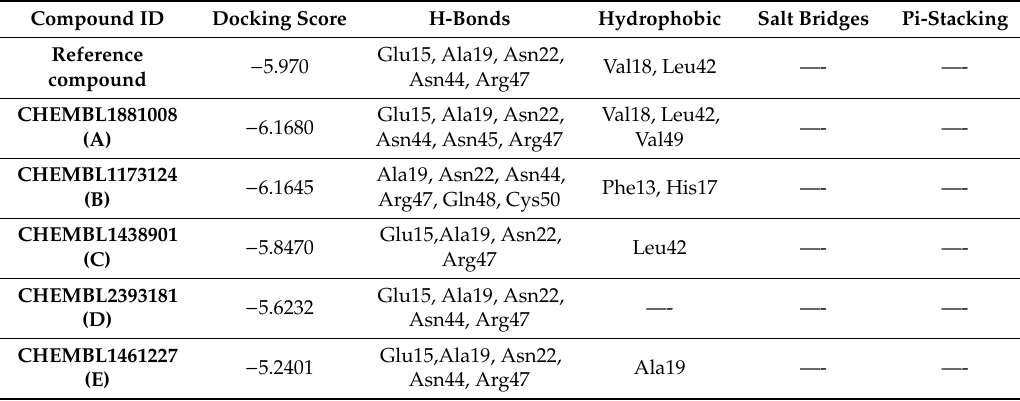
Table 2. Molecular interactions between protein-ligand